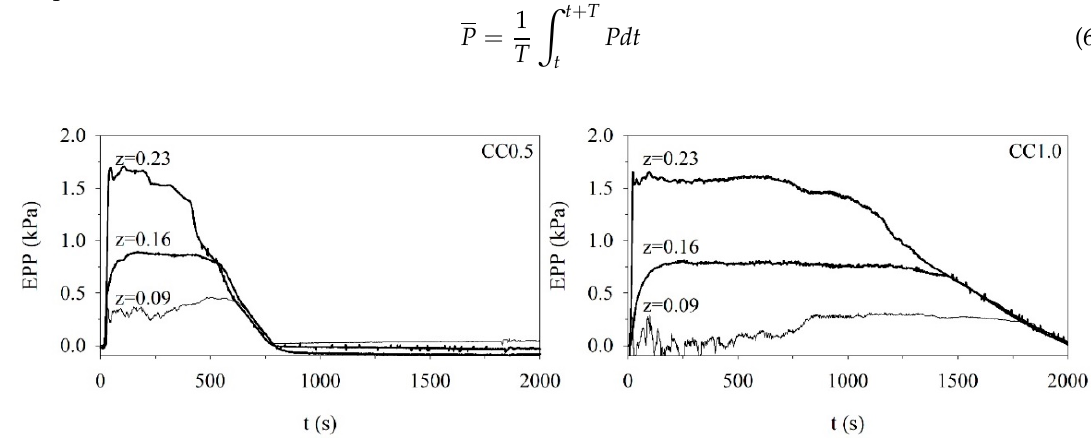
Figure 5. Period-averaged EPP in low clay contents (CC) bed (the wave height is 0.14 m and the wave period is 1.6 s).